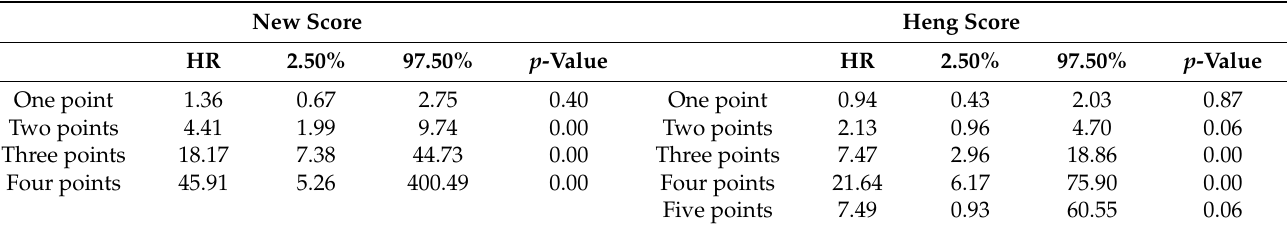
Figure 2. Kaplan–Meier plots of overall survival of patients divided by number of risk factors, by our new model ( A ) and by Heng’s criteria model ( B ). Separation of the patients into two risk groups, high risk (defined by having two or more risk factors) and low risk (fewer than two risk factors) of our new model ( C ) or Heng’s criteria model ( D ). Table 3. Hazard ratios for our new scoring system compared with the Heng